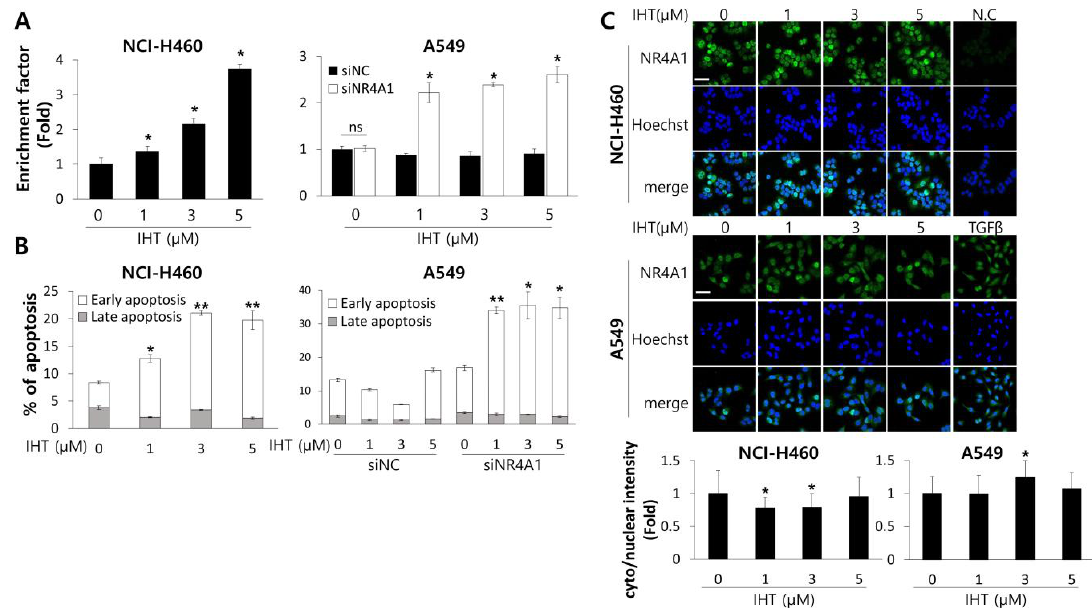
Figure 4. Treatment with IHT in NCI-H460 and with a combination of IHT and NR4A1 knockdown in A549 tumorspheroids increased apoptotic cell death. ( A ) Two days after ULA plating, NCI-H460 and siRNA-transfected A549 tumorspheroids were treated with the indicated concentrations of IHT for 72 h, and apoptosis was analyzed using the Cell Death detection ELISA kit. *, significantly different from control ( p < 0.05). n.s = not significant. ( B ) Dissociated tumorspheroids at 72 h after IHT treatment were analyzed by flow cytometry. Apoptotic cells are presented as a percentage of Annexin V-positive/7-amino-actinomycin D (7-AAD)-negative cells (early apoptosis) and of Annexin V/7-AAD double-positive cells (late apoptosis). *, significantly different from control ( p < 0.05). **, significantly different from control ( p < 0.01). ( C ) 2D-cultured A549 and NCI-H460 cells were treated with IHT for 5 h. Expression and localization of NR4A1 were assessed by immunofluorescence staining. The secondary antibody used for NR4A1 was labeled by Alexa 488 (green), and nuclei were stained by Hoechst 33342 (blue). Scale bars, 50 μm. *, significantly different from control ( p < 0.05). All data are presented as mean ± SD.